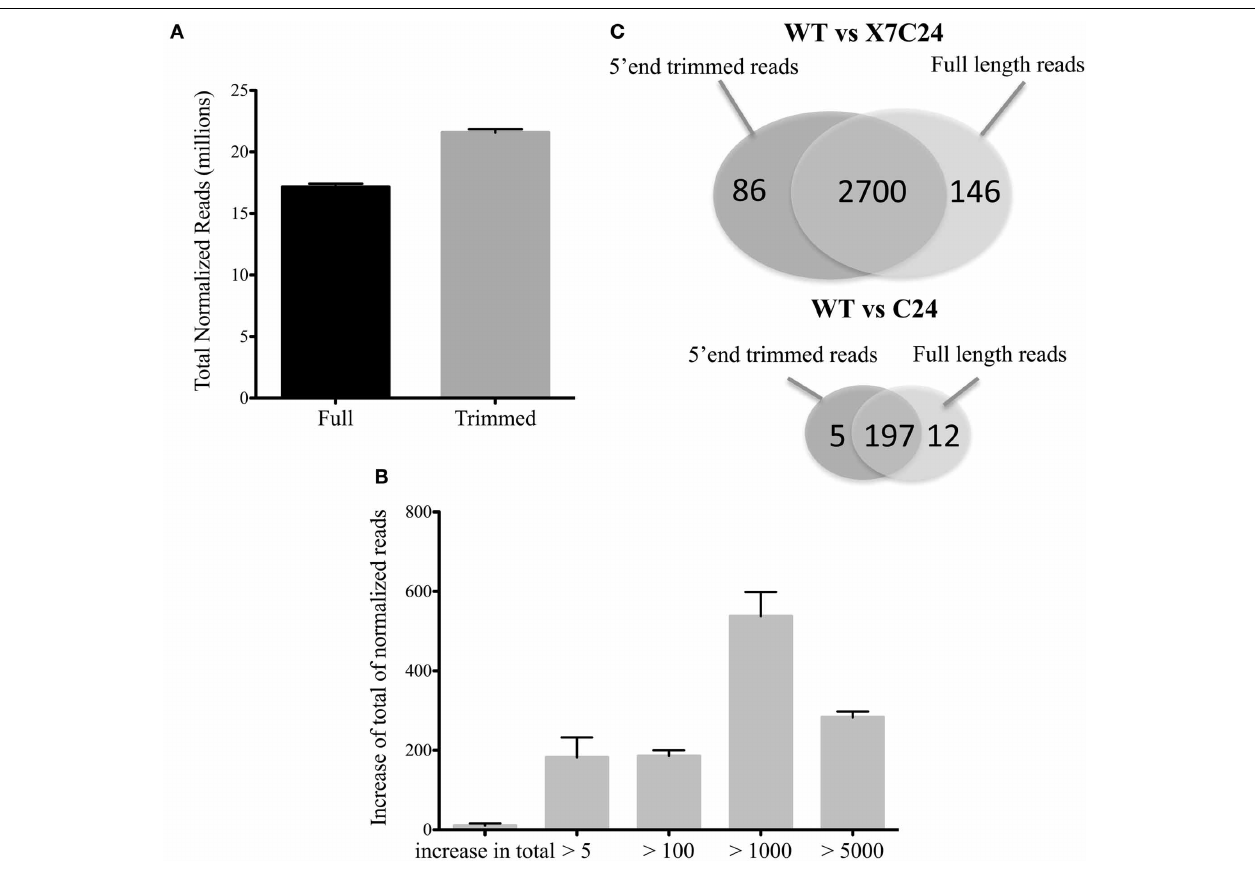
FIGURE 8 | Effect of 5 (cid:2) end trimming on gene coverage. (A) Total reads mapped to protein coding features after performing trimming of 10 nucleotides from 5 (cid:2) ends of all raw reads (Trimmed) and without trimming (Full) in all libraries of WT, C24, and X7/C24 that passed QC analysis. (B) Average gain and s.e.m of normalized reads mapped to protein coding genes after trimming, shown according to class of